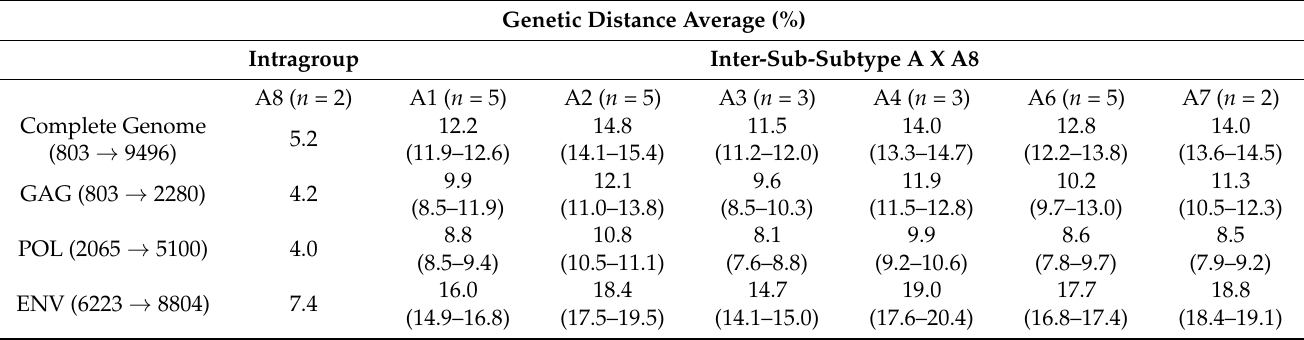
Table 2. Genetic distance between intragroup A8 and the other HIV-1 A sub-subtypes. Genetic Distance Average